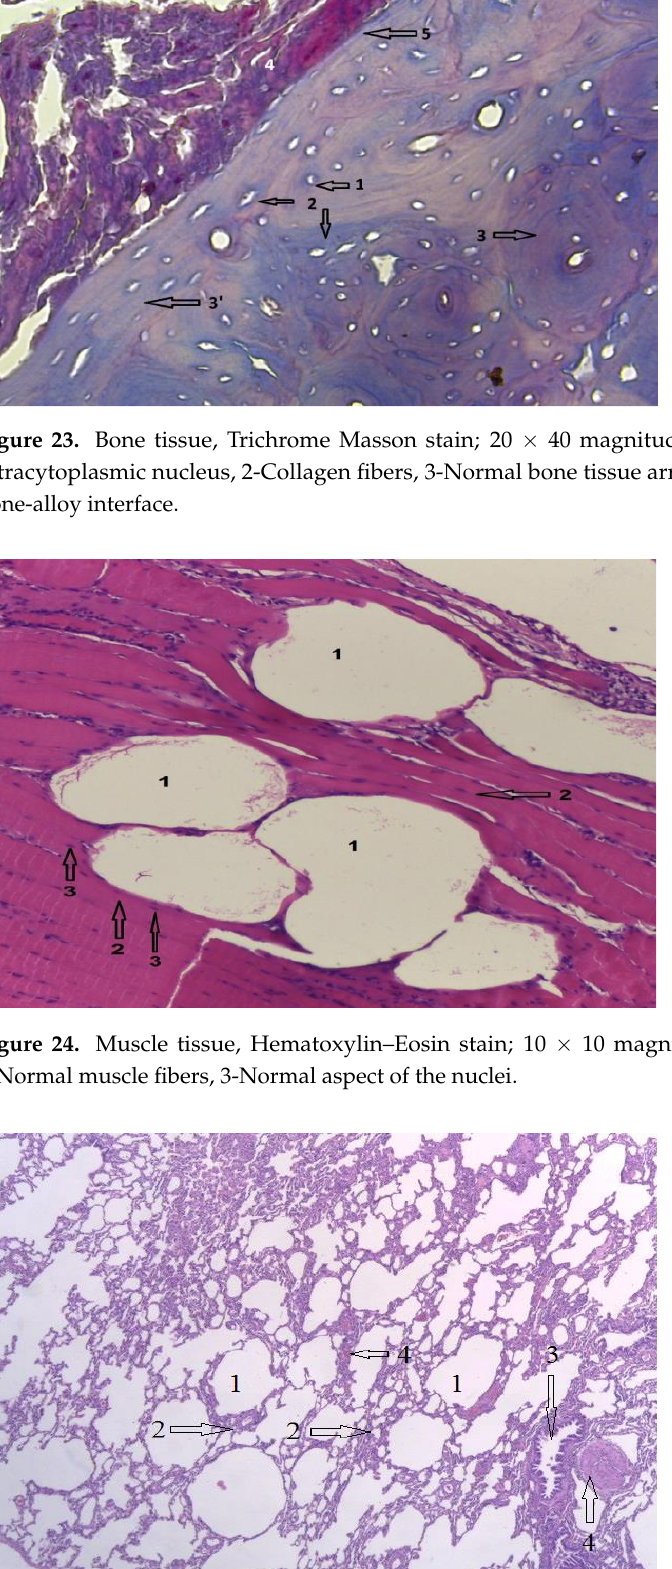
Figure 25. Lung tissue, H-E stain, 10 × 10. 1-Aspect of the alveoli, 2-Interstitial spaces, 3-Bronchioles, 4-Interalveolar blood vessels.